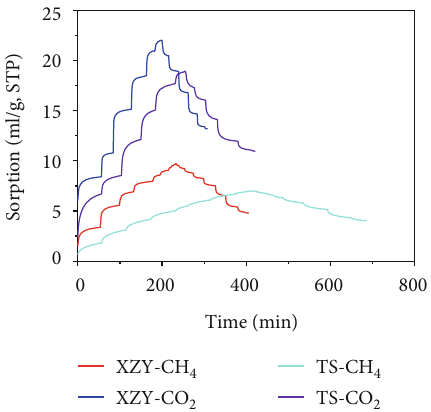
Figure 3: Gas sorption amount variation with time during the adsorption and desorption